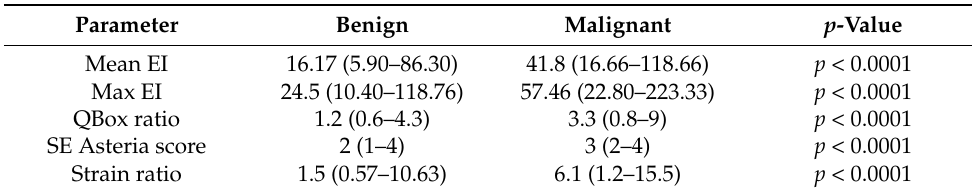
Table 6. Parameters of ultrasound SE and SWE elastography (median values and range interval) in the benign versus malignant thyroid nodules.